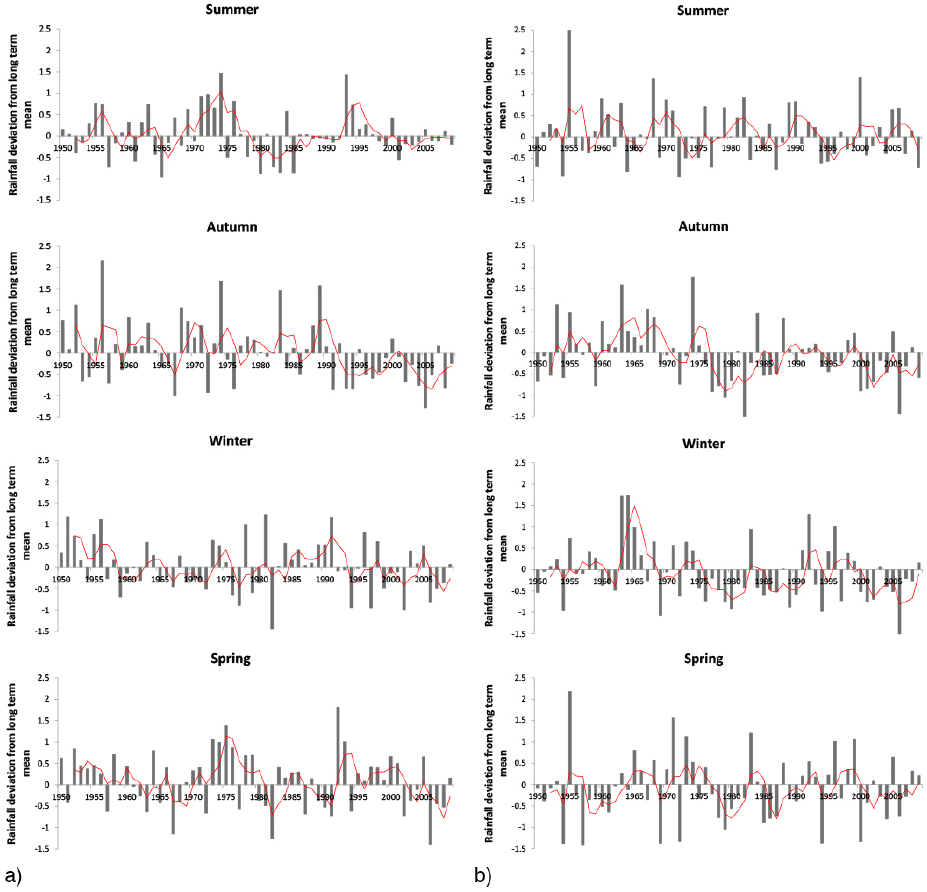
Figure 5. Rainfall deviation from the long-term mean (1900–2009) for (a) all SEA (left panel) and (b) all SWWA stations (right panel) combined. Note anomalies displayed from 1950 onwards.